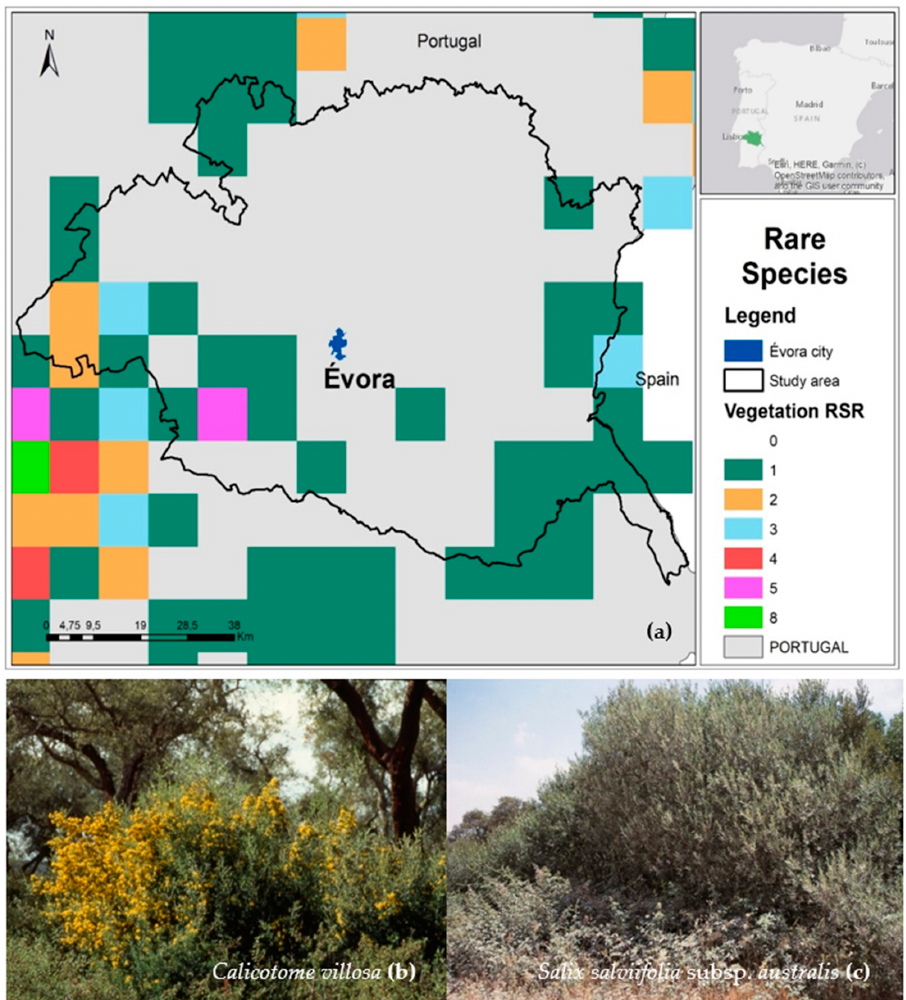
Figure 3. Rare vegetation species in the study area (Natura 2000 Annexes) (authors of the map ( a ): T. Batista, P. Mendes and C. P. Gomes) (author of the photos ( b ) and ( c ): J.M. de Mascarenhas). The phytocoenosis maturity criterion allows us to perceive the state of proximity to the climax situation wich is relevant in terms of conservation management. In the study area it was considered that the vegetation is mainly in two phytocenotic stages: low (the case of montados with crops) and medium (montados with high shrubs). The vegetation corridors are also important landscape features, not only as habitat, but also due to the barrier effect and the fact that they favour the connectivity of fauna species. In this analysis, we mapped the most structured and lush vegetation river corri ‐ dors, composed of arboreal and shruby vegetation (Figure 4) .